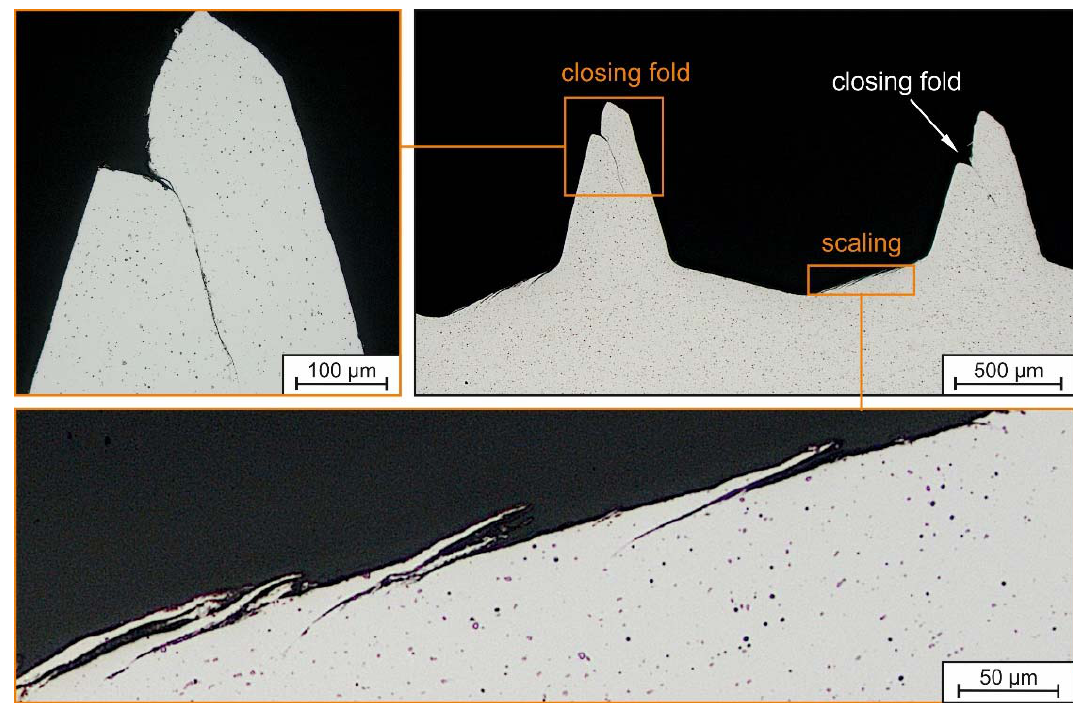
Figure 9. Optical micrograph of a longitudinal section of a threaded part processed by route A. The thread teeth are not fully formed and as a result, the closing fold at the tip of the tooth is clearly visible and has a crack-like appearance. Further, the thread root exhibits distinct scaling.